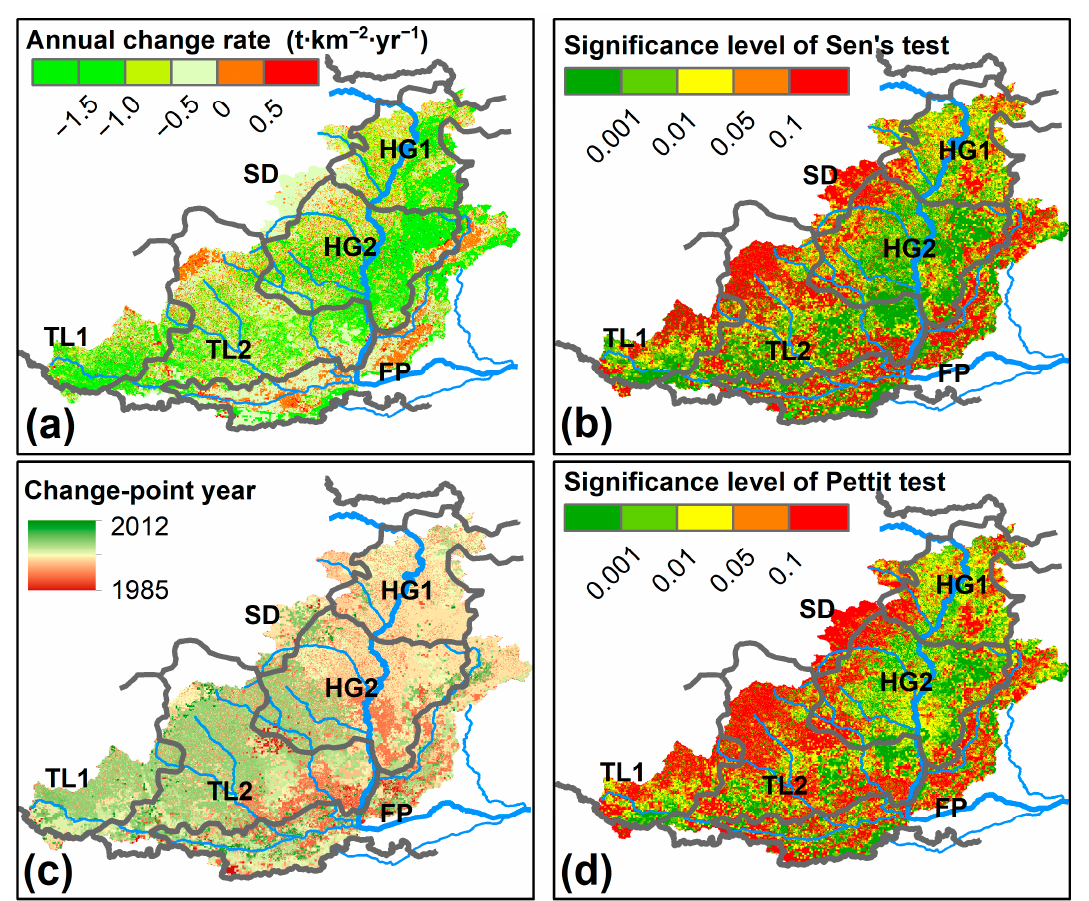
Figure 5. Temporal changes in SOC loss in the Hetong region. ( a ) Change rates of SOC loss, ( b ) their statistical significance, ( c ) detected change-point years of SOC loss, and ( d ) the statistical significance of the Pettitt test.